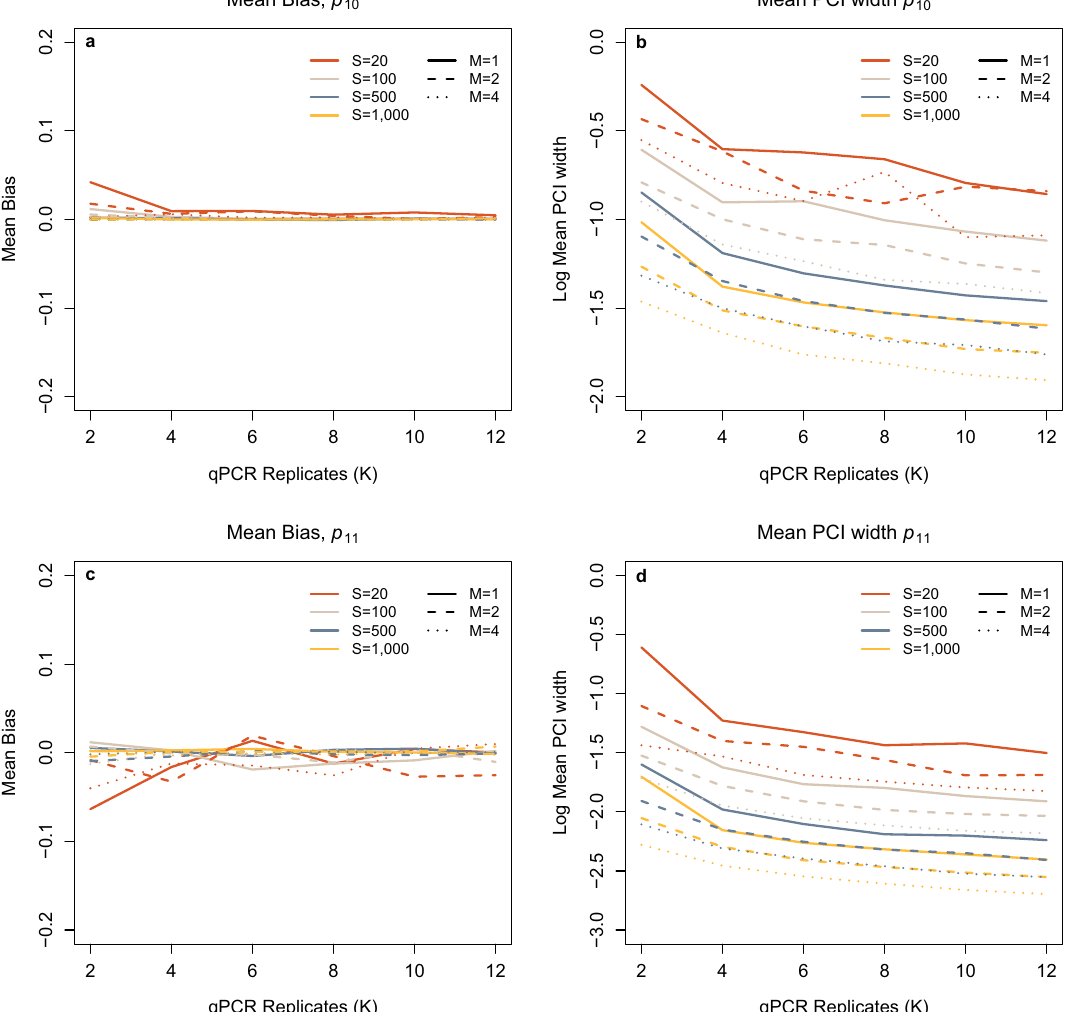
Figure 4. ( a ) Mean Bias in Stage 1 false positives ( p 10 ) estimate with varying numbers of sites (S), samples collected (M) and qPCR replication (K). ( b ) Mean 95% PCI width for Stage 1 false positives ( p 10 ) plotted on a logarithmic scale, with varying numbers of sites (S), samples collected (M) and qPCR replication (K). ( c ) Mean Bias in Stage 1 true positives ( p 11 ) estimate with varying numbers of sites (S), samples collected (M) and qPCR replication (K). ( d ) Mean 95% PCI width for Stage 1 true positives ( p 11 ) plotted on a logarithmic scale, with varying numbers of sites (S), samples collected (M) and qPCR replication (K).